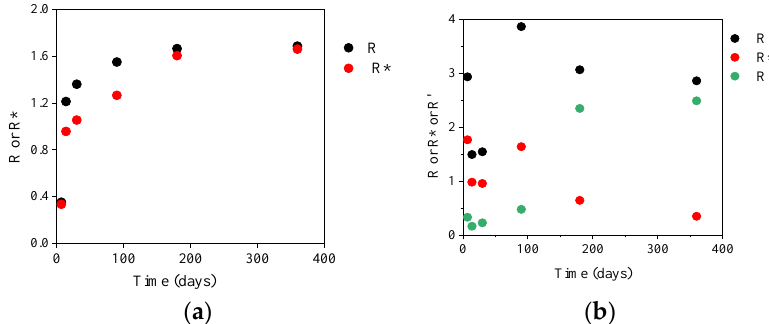
Figure 5. Evolutions of the ratio R = I O /I Mg and R* = I O /(I Mg + I Si ) for SP or R = (I O + I F )/I Mg , R* = (I O + I F )/(I Mg + I Si ) and R’ = I F /I Mg for NaF-SP as a function of the corrosion time of MgZr substrate in ( a ) PS and ( b ) NaF-PS.